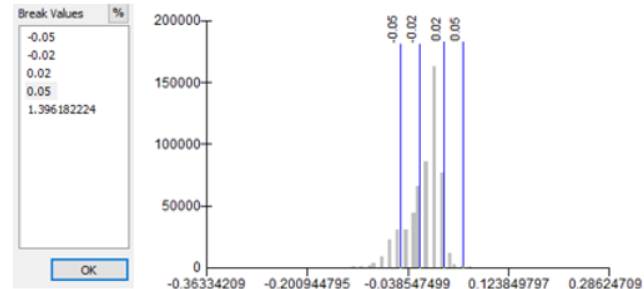
Figure 10. Histograms with values from Landsat 8 and Sentinel- 2 corrected with iCOR.